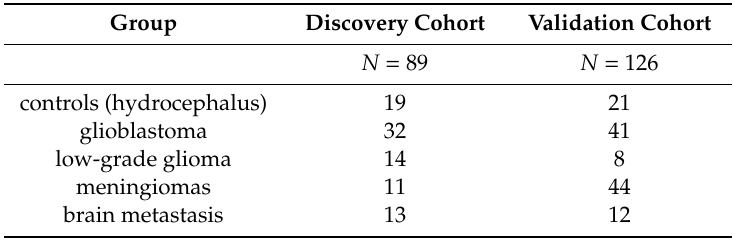
Table 1. Groups of patients included in this